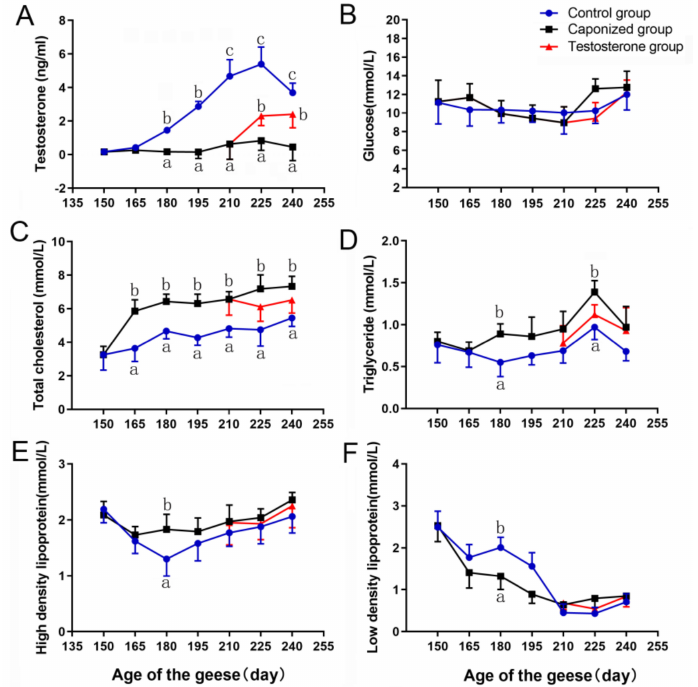
Figure 2. Serum testosterone and metabolite concentrations of the control group ( • ), the caponized group ( (cid:4) ), and the testosterone group ( (cid:78) ). ( A ) (Testosterone), ( B ) (glucose), ( C ) (triglycerides), ( D ) (cholesterol), ( E ) (high − density lipoprotein), ( F ) (low − density lipoprotein). Data are shown as mean values ± standard error of the mean. Different letters above the bars denote significant differences (a,b: p < 0.05; b,c: p < 0.05; a–c: p <